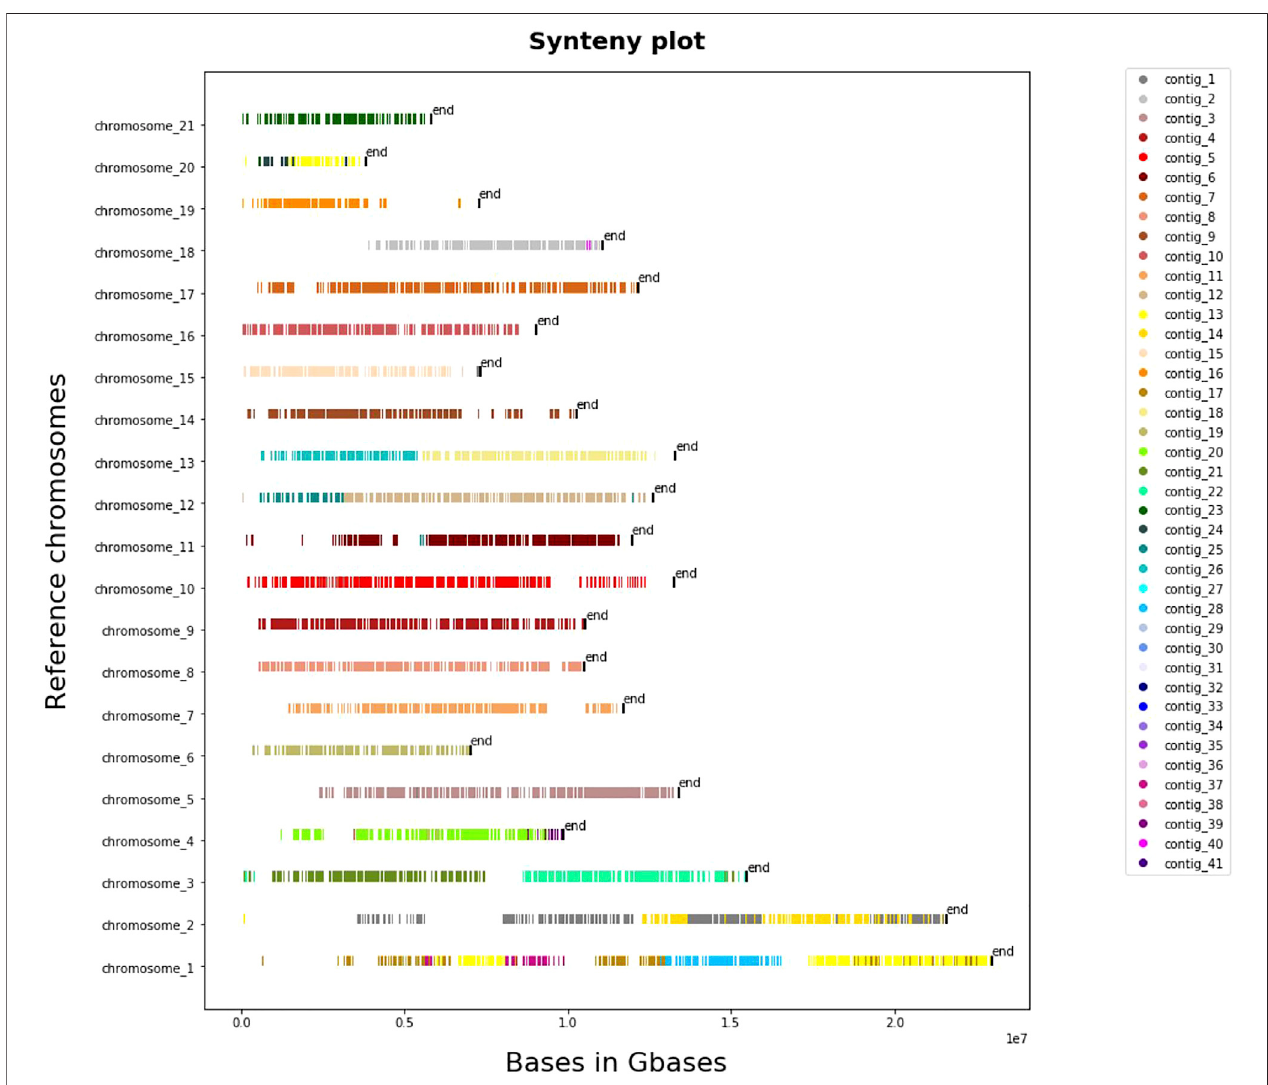
FIGURE4| Syntenyplotofpairwisewholegenomealignmentof L.sceleratus against T.nigroviridis. Theplotillustratesthecontigsofthe L.sceleratus alignedto T. nigroviridis chromosomes (y-axis), grouped by a speci fi c color which are represented on the legend right to the plot.